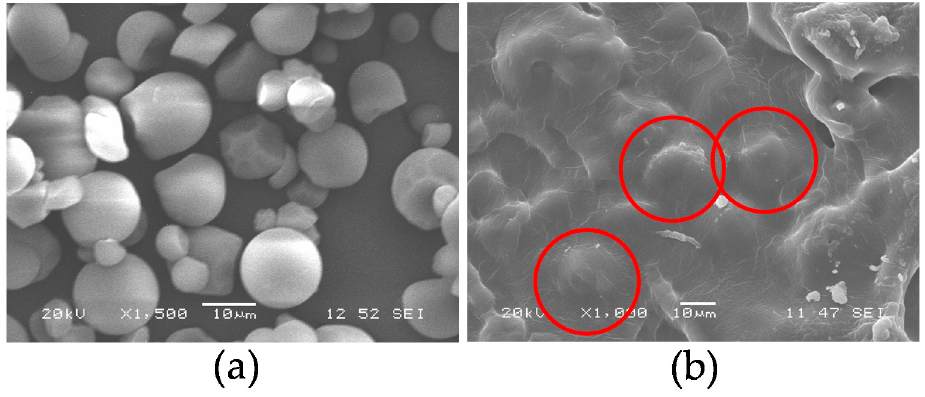
Figure 2. Scanning electron images of: ( a ) unplasticized starch particles; ( b ) fracture surfaces at tension of the TPS at 54% relative humidity and 17 days of storage. The red circles show a few granules that are not completely destructured.